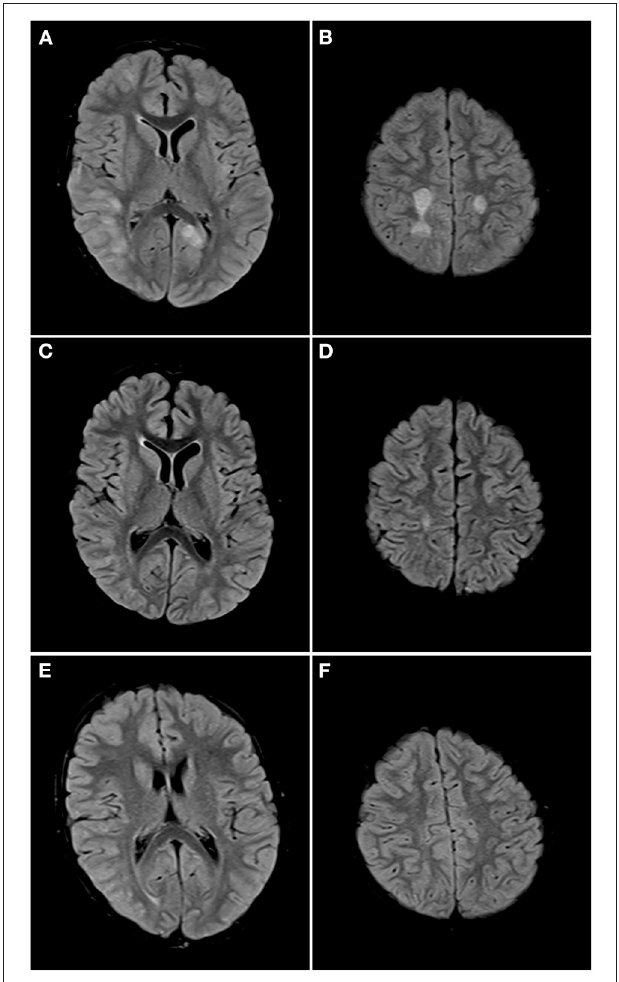
FIGURE 5 | Axial FLAIR images of the brain from the same patient across serial examinations. (A,B) At the time of disease presentation: FLAIR hyperintense lesions involve the cortex and subcortical white matter of the right posterior temporal, right lateral occipital and left parasagittal occipital lobes (A) and the centrum semiovale bilaterally (B) . (C,D) Approximately 1 month later: The lesions in both cerebral hemispheres have nearly completely resolved with a small residual lesion in the right centrum semiovale. (E,F) One year later: All the lesions have completely resolved.